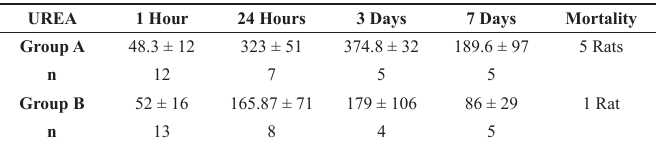
TABLE 1 - Mean ± SEM serum urea levels (mg%) of animals submitted to warm renal ischemia for 1 hour followed by contralateral nephrectomy, pretreated or not with lovastatin at the dose of 15 mg/kg/day for ten days.